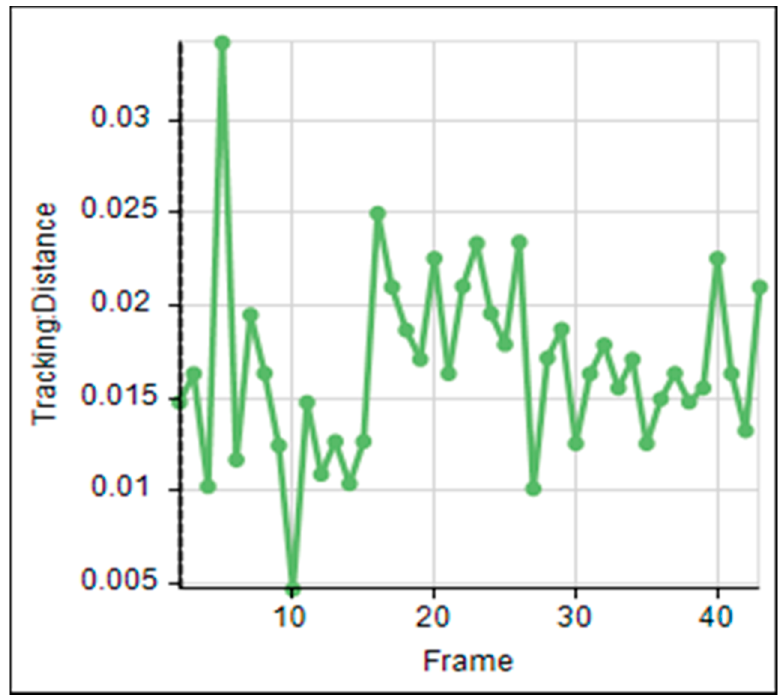
Figure 20. The relation between the frame and tracking distance of the insect (m).